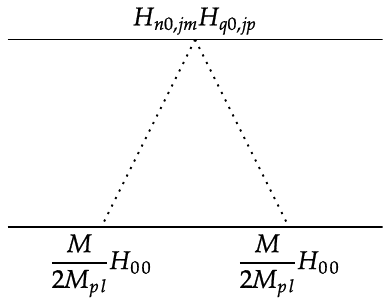
Figure 3 . Leading Order B-potential.